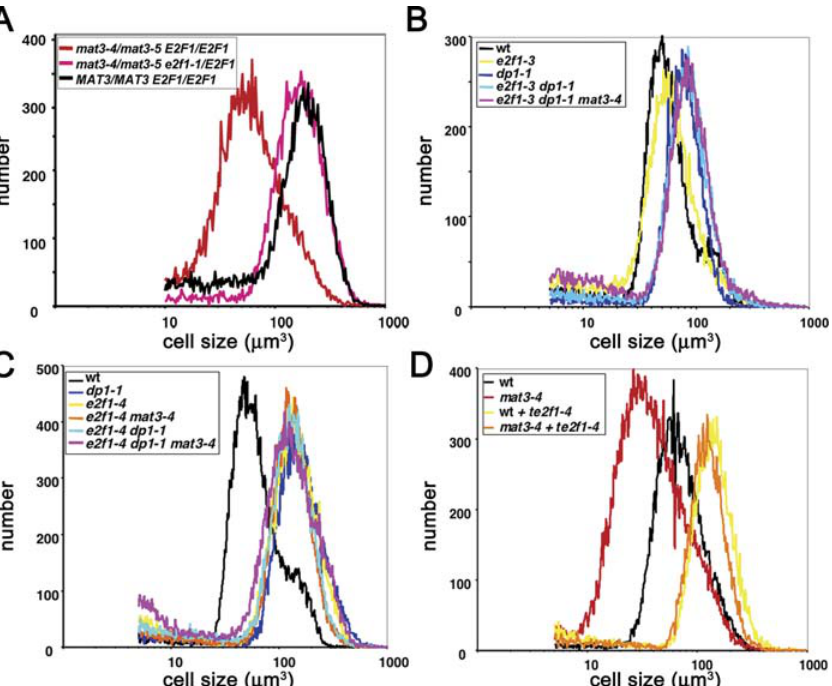
Figure 6. Dominance Testing and Genetic Interactions of e2f1 Mutants (A) Size distributions of dark-shifted vegetative diploids of indicated genotype. (B) Size distributions of dark-shifted wild-type, e2f1–3 , dp1–1 , e2f1–3 dp1–1, and e2f1–3 dp1–1 mat3–4 strains. (C) Size distributions of dark-shifted wild-type, dp1–1 , e2f1–4 , e2f1–4 mat3–4, e2f1–4 dp1–1 , and e2f1–4 dp1–1 mat3–4 strains. (D) Size distributions of dark-shifted wild-type and mat3–4 with and without a transgenic e2f1–4 allele ( te2f1–4